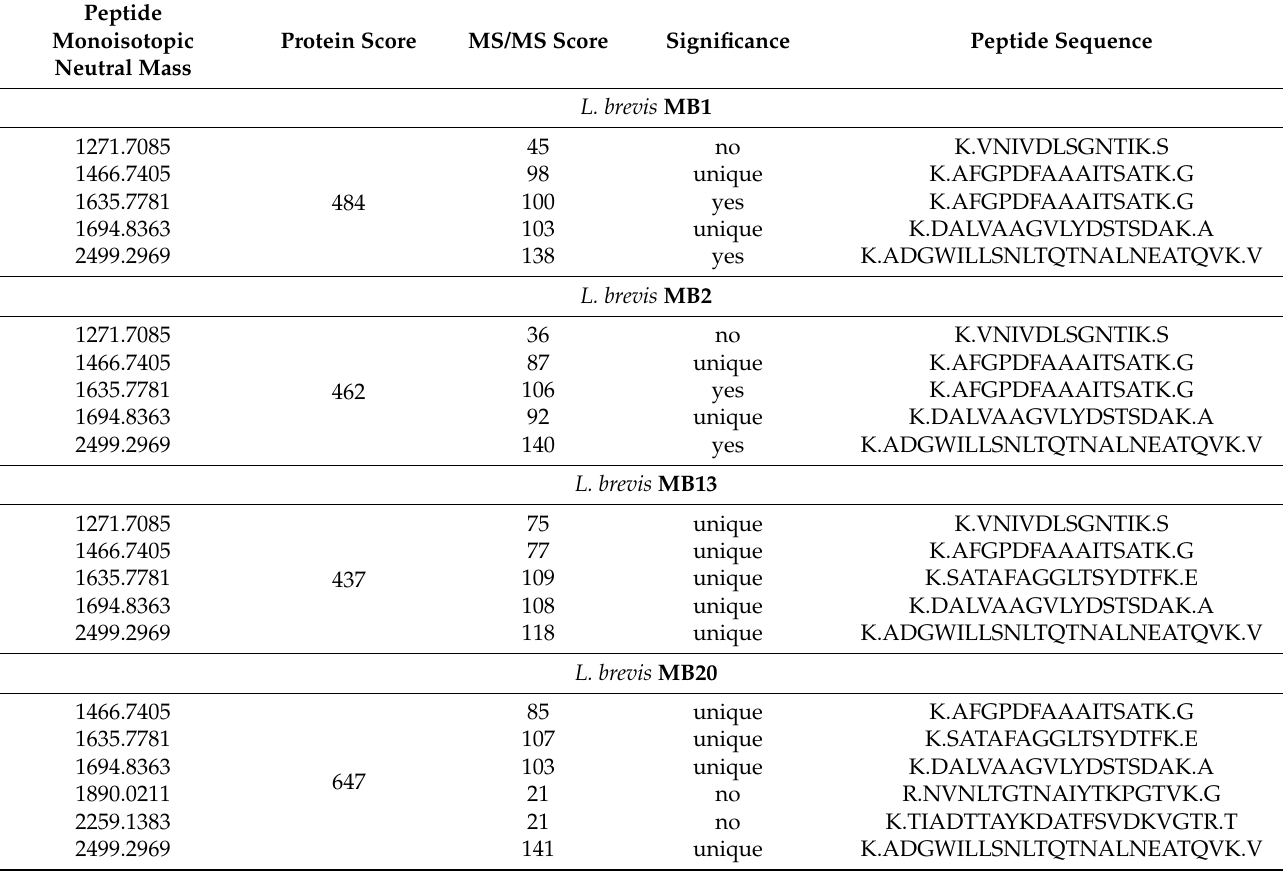
Table 2. S-layer proteins of L. brevis MB1, MB2, MB13 and MB20 identified by SDS-PAGE coupled with LC-MS and Mascot database